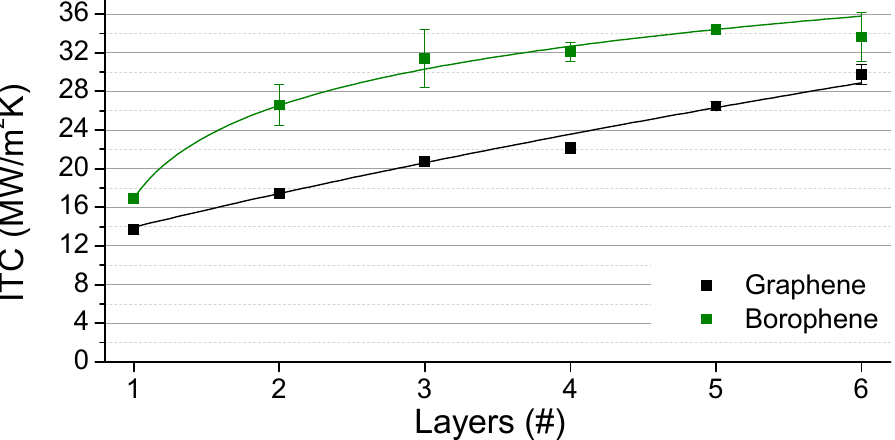
Figure 3. Interfacial thermal conductance (ITC) between nanosheets and PDMS as a function of the number of layers of graphene and borophene. The line guides the eye among actual values (squares).